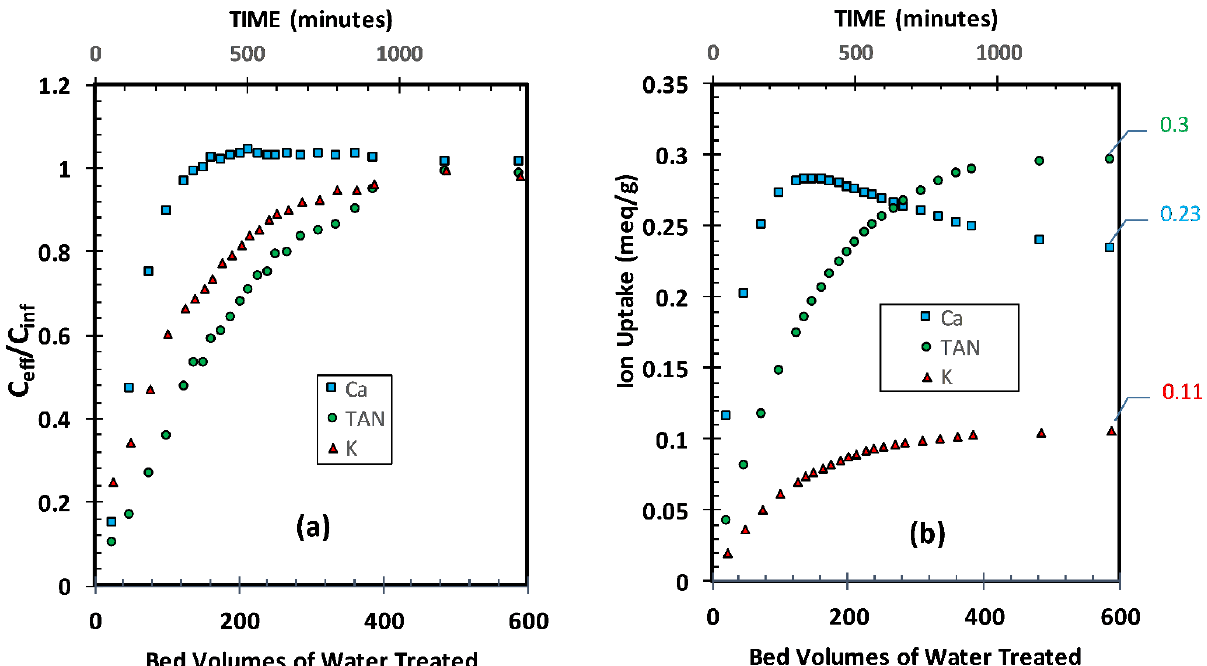
Figure 1. Second 23 h loading cycle with chlorine regeneration (CL2): ( a ) breakthrough; ( b ) ion uptake versus bed volumes of water treated.